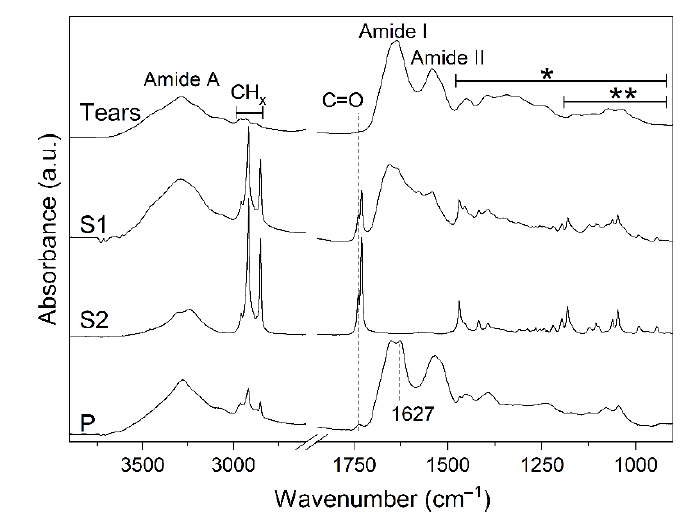
Figure 3. Fourier transform infrared (FTIR) spectra of protein extraction phases. Tears, unprocessed sample; S1, aqueous layer; S2 organic solvent layer; P, pellet. The wavenumber and the assignment of selected peaks are shown. * Overlapping absorption of lipids (hydrocarbon chains/head groups) and proteins; ** Overlapping absorption of carbohydrates and